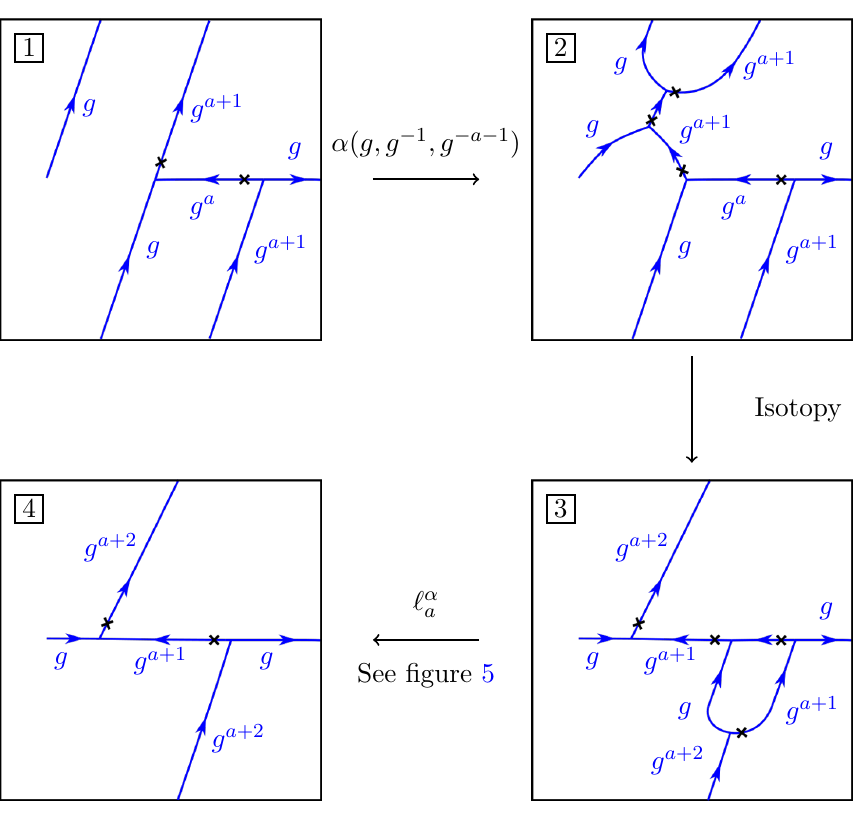
, where the phase ‘ α a a